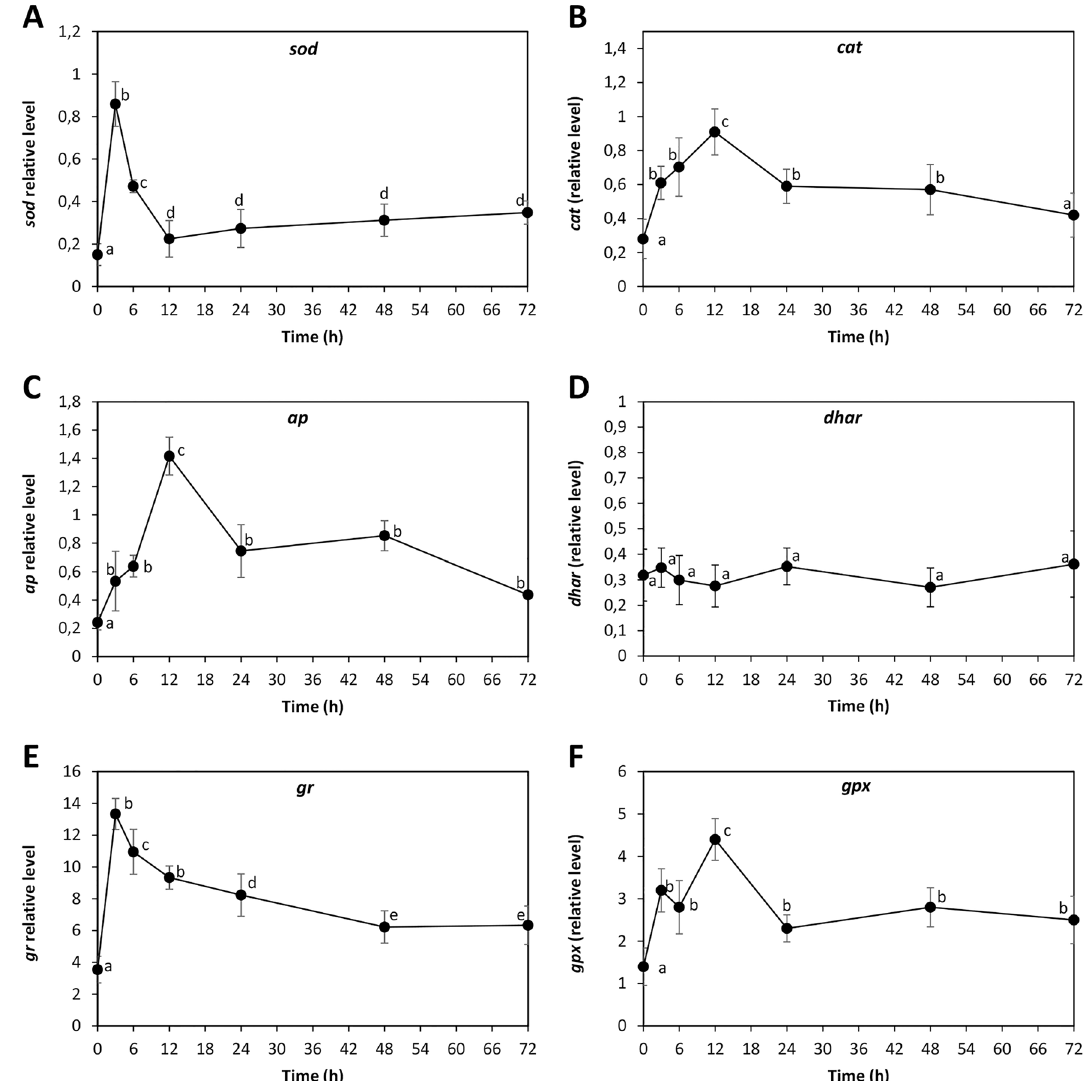
Figure 5. Relative level of transcripts encoding antioxidant enzymes superoxide dismutase ( A ), catalase (B), ascorbate peroxidase ( C ), dehydroascorbate reductase ( D ), glutathione reductase ( E ) and glutathione reductase ( F ) in U. lactuca cultivated with 5 μM anthracene for 0–72 h (black circles). The relative level of transcripts is expressed as 2 −ΔΔCT . Symbols represent mean values of three independent experiments ± SD. Letters indicate significant differences among experiments ( P <